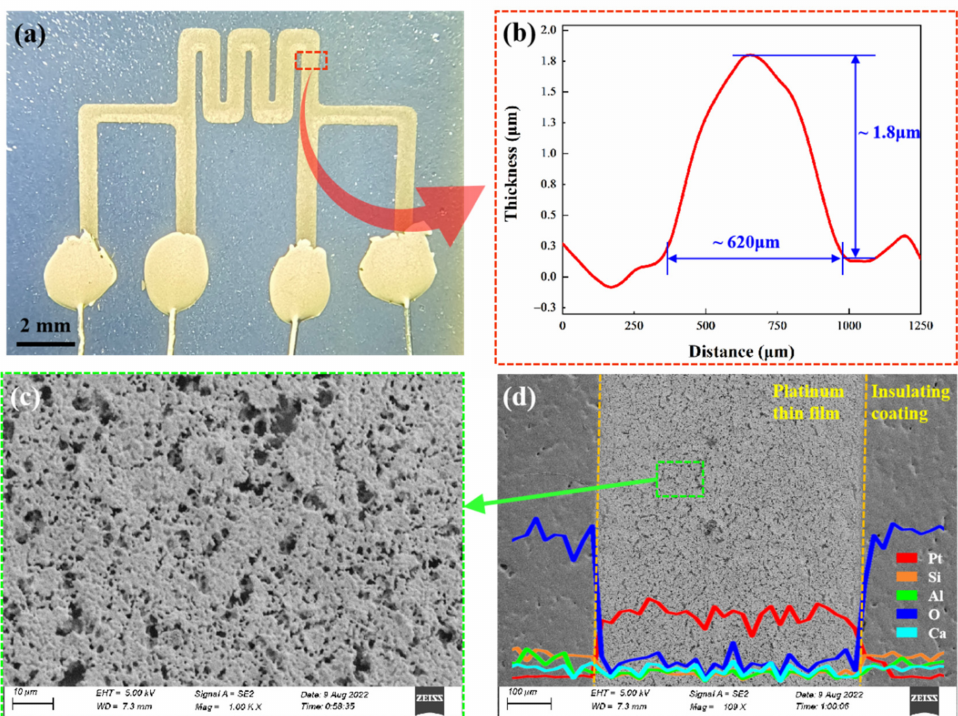
Figure 3. ( a ) Optical image of a printed Pt thin-film strain gauge. ( b )Thickness of the Pt TFSG. ( c ) SEM images of the Pt sensitive thin film. ( d ) EDS analysis of the Pt TFSG